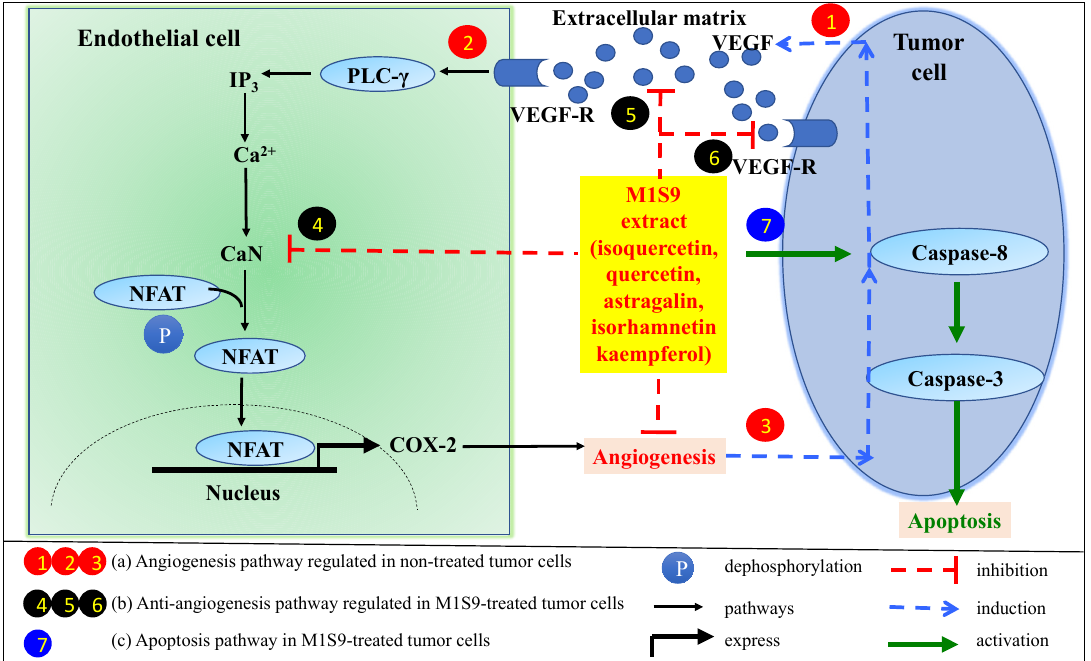
Figure 4. Possible pathways involved in tumorigenesis, angiogenesis and cell apoptosis. ( a ) Angiogenesis pathway in non-treated tumor cells. (1) Tumor cells secrete VEGF into the extracellular matrix and then bind to VEGFR on endothelial cells to activate the NFAT signaling cascade for VEGF- induced angiogenesis. (2) VEGFR pathway activates phospholipase C γ (PLC γ ) and releases calcium via inositol-1,4,5-triphosphate (IP3) to activate calcineurin (CaN) activity via calmodulin (a calcium- binding protein). Activated CaN regulates NFAT dephosphorylation to enter into nucleus to regulate cyclooxygenase-2 (COX-2) gene expression that can stimulate angiogenesis process. (3) VEGF- mediated angiogenesis induces more VEGF secretion for blood vessel formation. ( b ) Anti- angiogenesis pathway in M1S9-treated tumor cells. (4) M1S9 extract might inhibit CaN activity without inducing NFAT pathway. As a consequence, it will limit (5) VEGF release from tumor cell and limit (6) the dimer formation of VEGF to VEGF-R. ( c ) Apoptosis pathway in M1S9-treated tumor cells. (7) M1S9 extract activates caspase-8 in tumor cell that govern the apoptosis pathway (adapted and modified from Zhao et al., 2016).